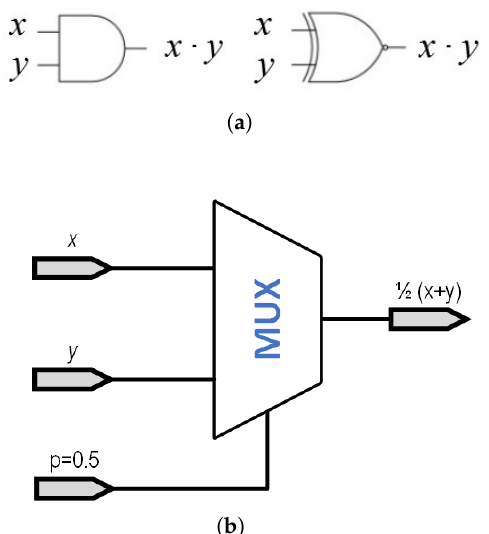
Figure 4. Basic implementation of basic operation in SC. ( a ) Basic implementation scheme of a SC multiplier in the ( 0 . . . 1 ) range (AND gate, left) and in the ( − 1 . . . 1 ) range (XNOR gate, right). ( b ) Basic implementation scheme of a SC adder using a